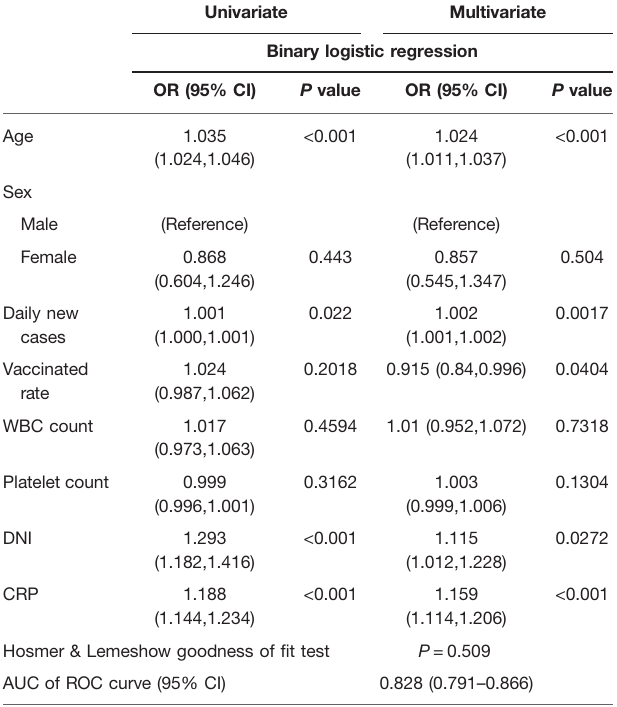
TABLE 5 | Univariate & Multivariate binary logistic regression for complicated appendicitis and Ordinal regression for numbers that meet the criteria for complicated appendicitis.